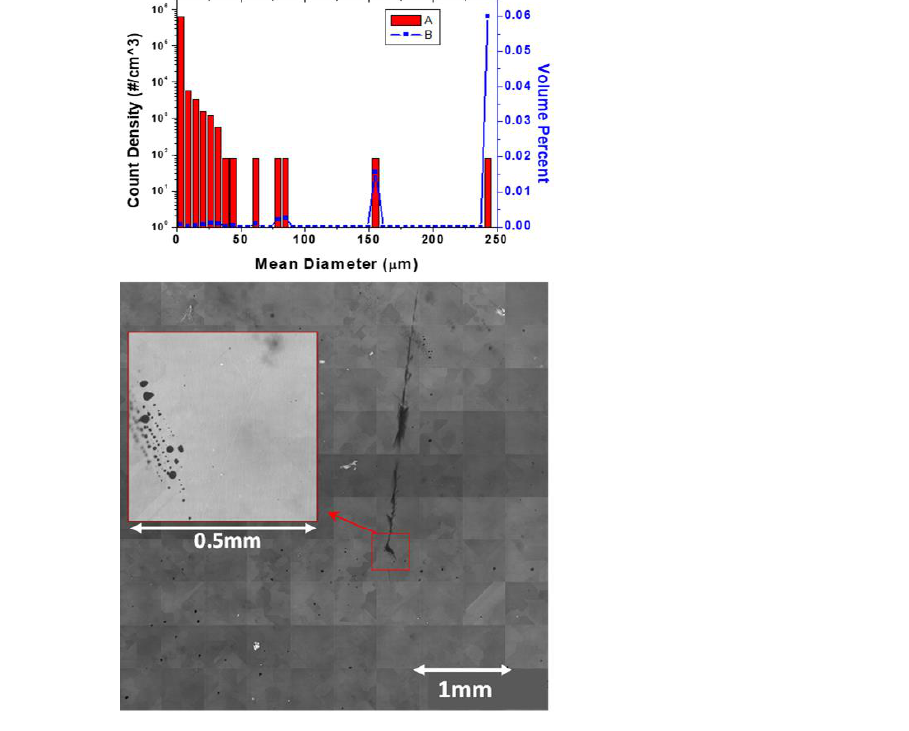
Figure 4. CRY-2, 5 × 5 mm 2 sample; ( top ) Te inclusions with average density ~6.4 × 10 5 cm −3 and size ~1.2 µm. ( bottom ) 2D-IR image, Te decorated twins in tiled images of the sample. Inset showing the triangular defects and alignment of the inclusions.